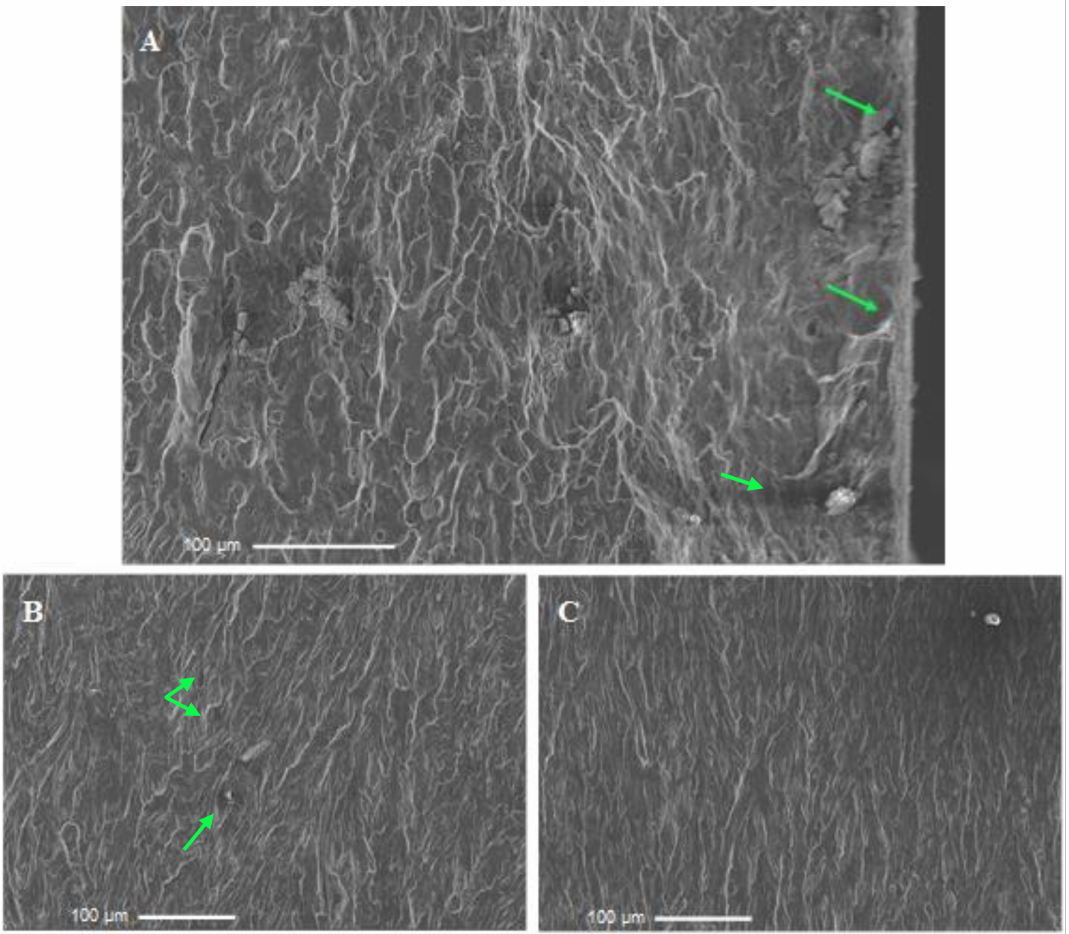
Figure 13. Fatigue fracture morphologies of the anodized specimen tested in the PBS solution at 92.5 MPa at room temperature. The images ( A – C ) correspond to the three different regions pointed out in the Figure